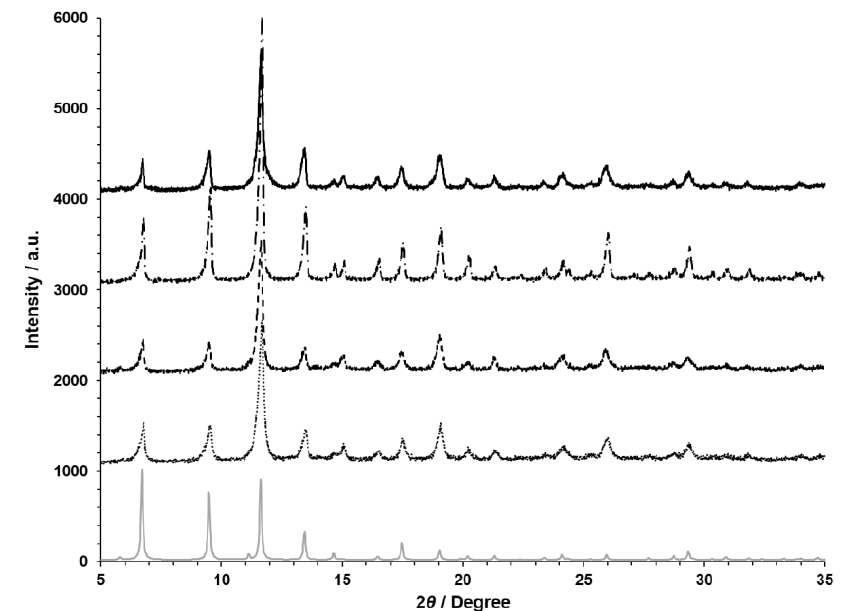
Figure 3. Powder X-ray diffractograms (from top to bottom) of: commercially available Basolite C300 (Cu-BTC; HKUST-1) (black solid line), MOF-2 (black dashed-dot line), MOF-3 (black short dashed line), MOF-4 black (dotted line), and simulated (solid gray).